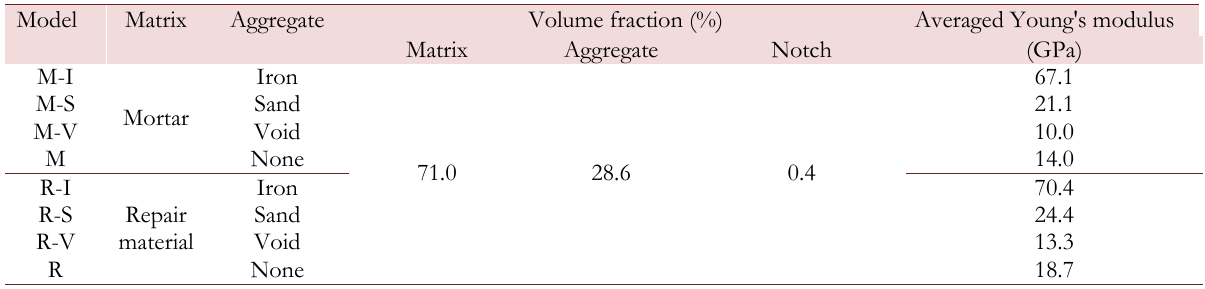
Table 5: Features of the monolithic models for FEM